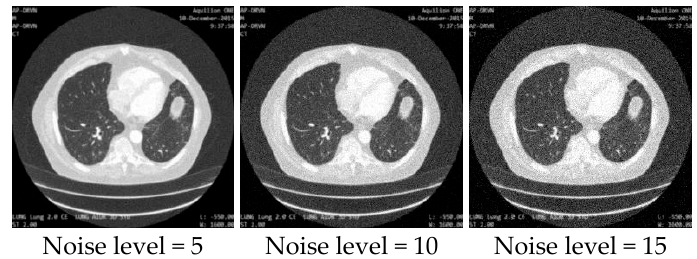
Figure 11. Sampled images with low resolution and different noise levels as the dataset for the image quality enhancement network.